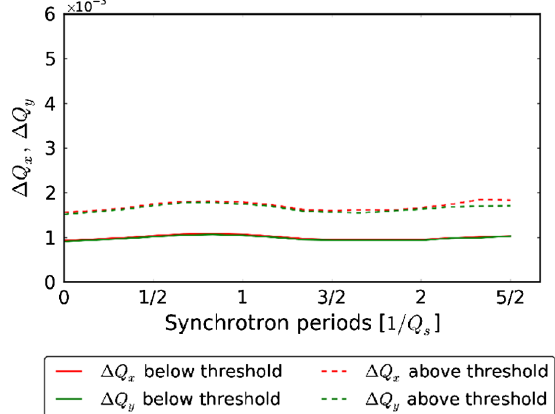
FIG. 24. Incoherent tune shift evolution at 3.5 TeV and a transverse normalized emittance of 2 : 5 (cid:3) m for different cases. FIG. 25. Incoherent tune spread evolution at 3.5 TeV and a transverse normalized emittance of 2 : 5 (cid:3) m in straight sections (top) and in bending magnets